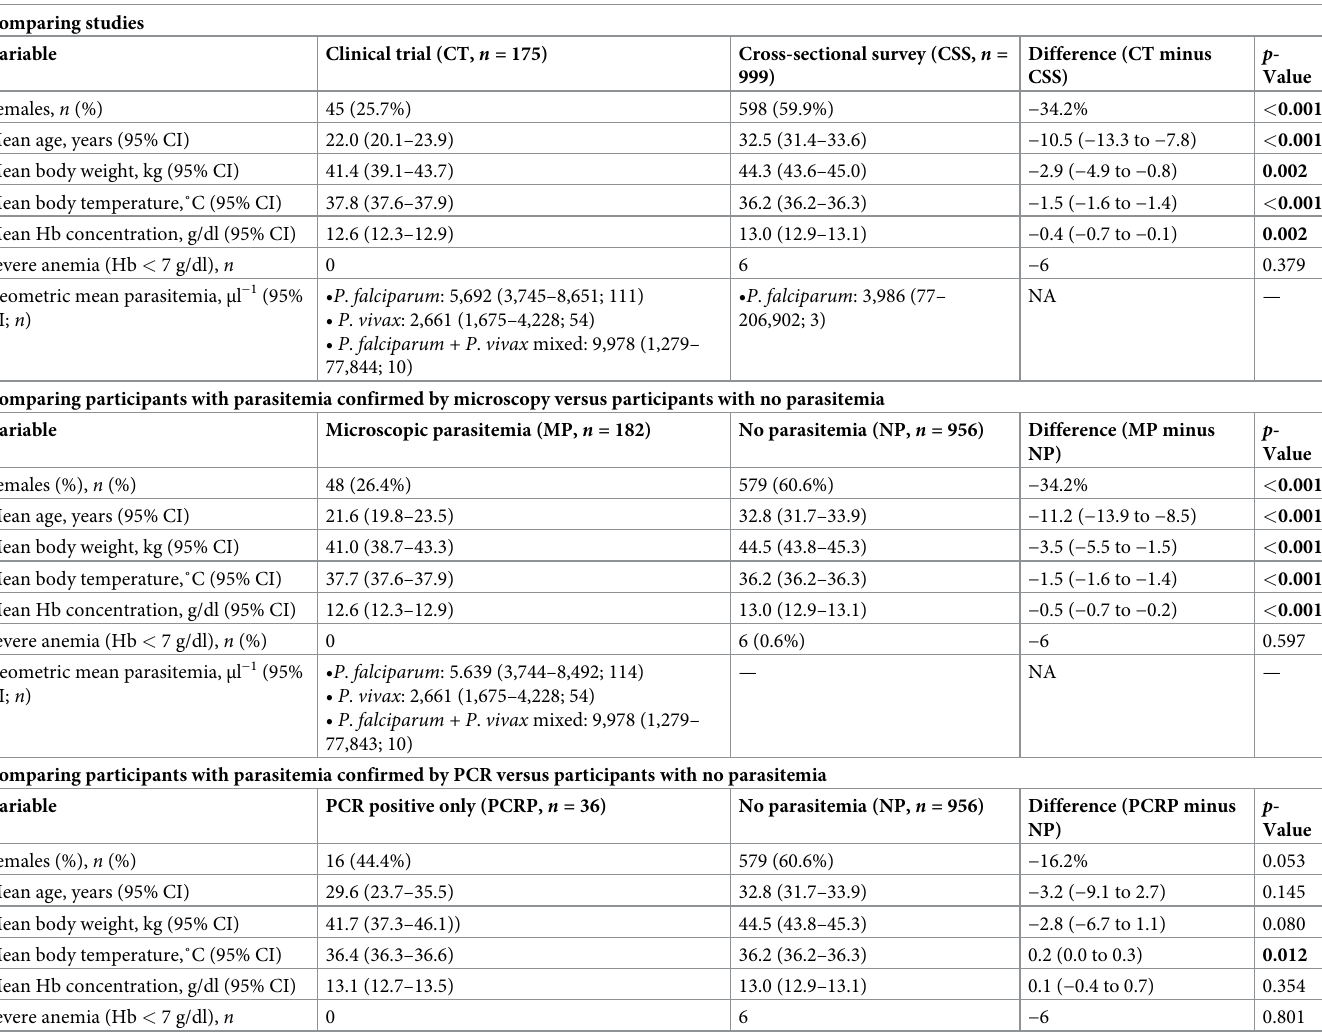
Table 1. Baseline variables stratified by study, and by microscopic malaria and submicroscopic malaria, for participants of the treatment efficacy trail and cross- sectional survey. Comparing